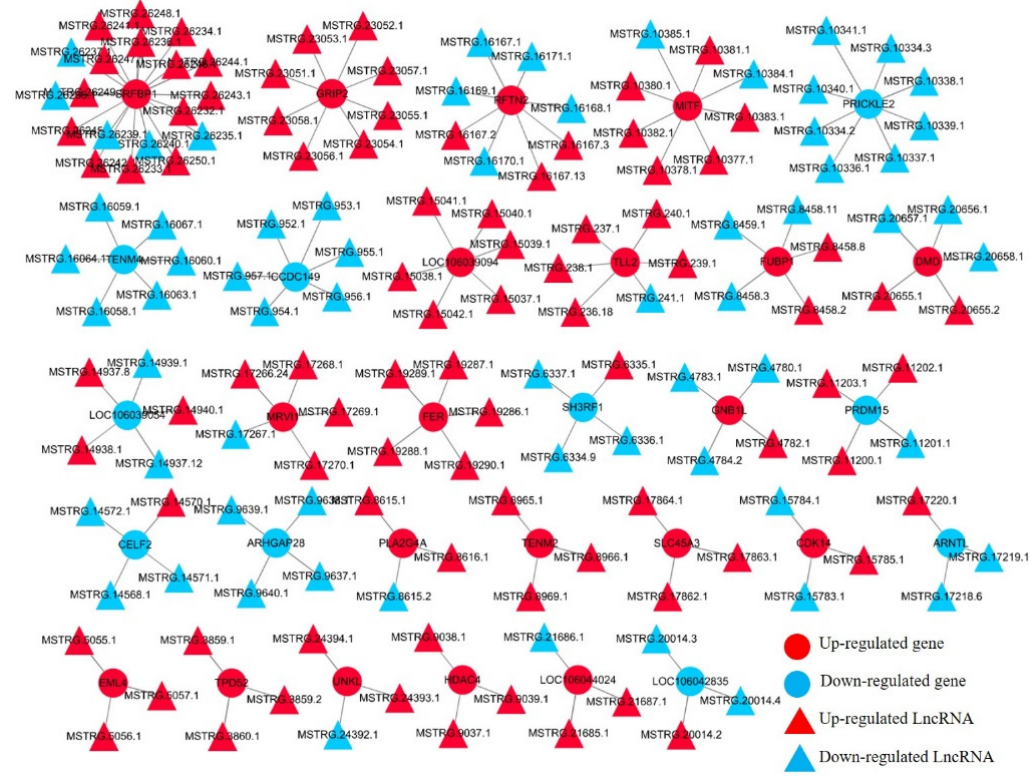
Figure 6. A DE-lncRNA-DEGs interaction network during goose myogenesis.